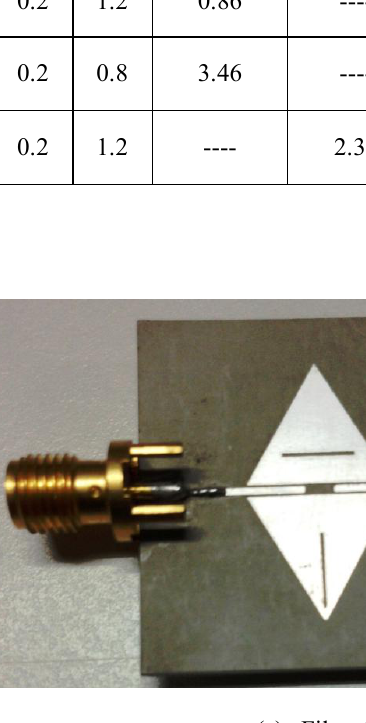
Figure 9: Photographs of the fabricated two pole and four pole